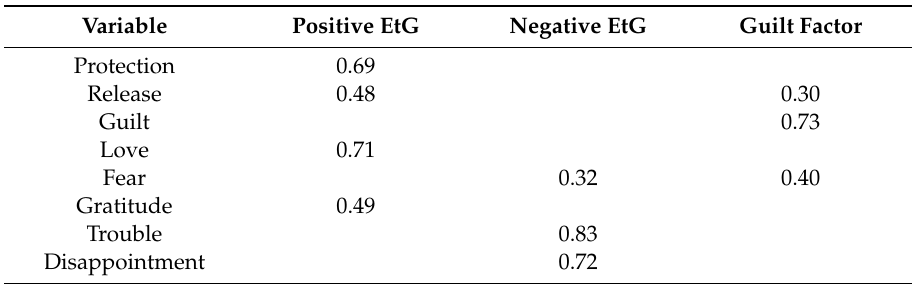
Table 7. Structure of the factors of the emotions towards God for “highly religious” Protestant adolescents and young adults.